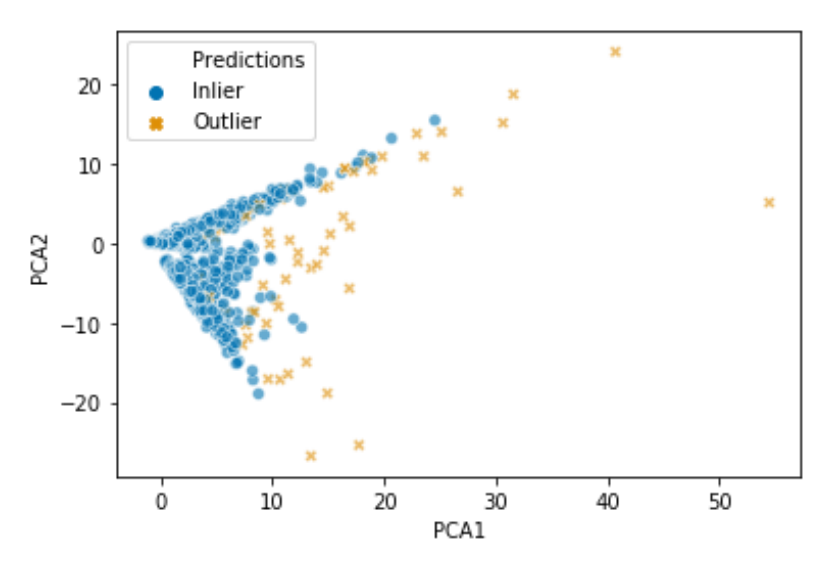
Figure 1. The results of the anomaly detection. PCA1 and PCA2 are two dimensions created using Principal Component